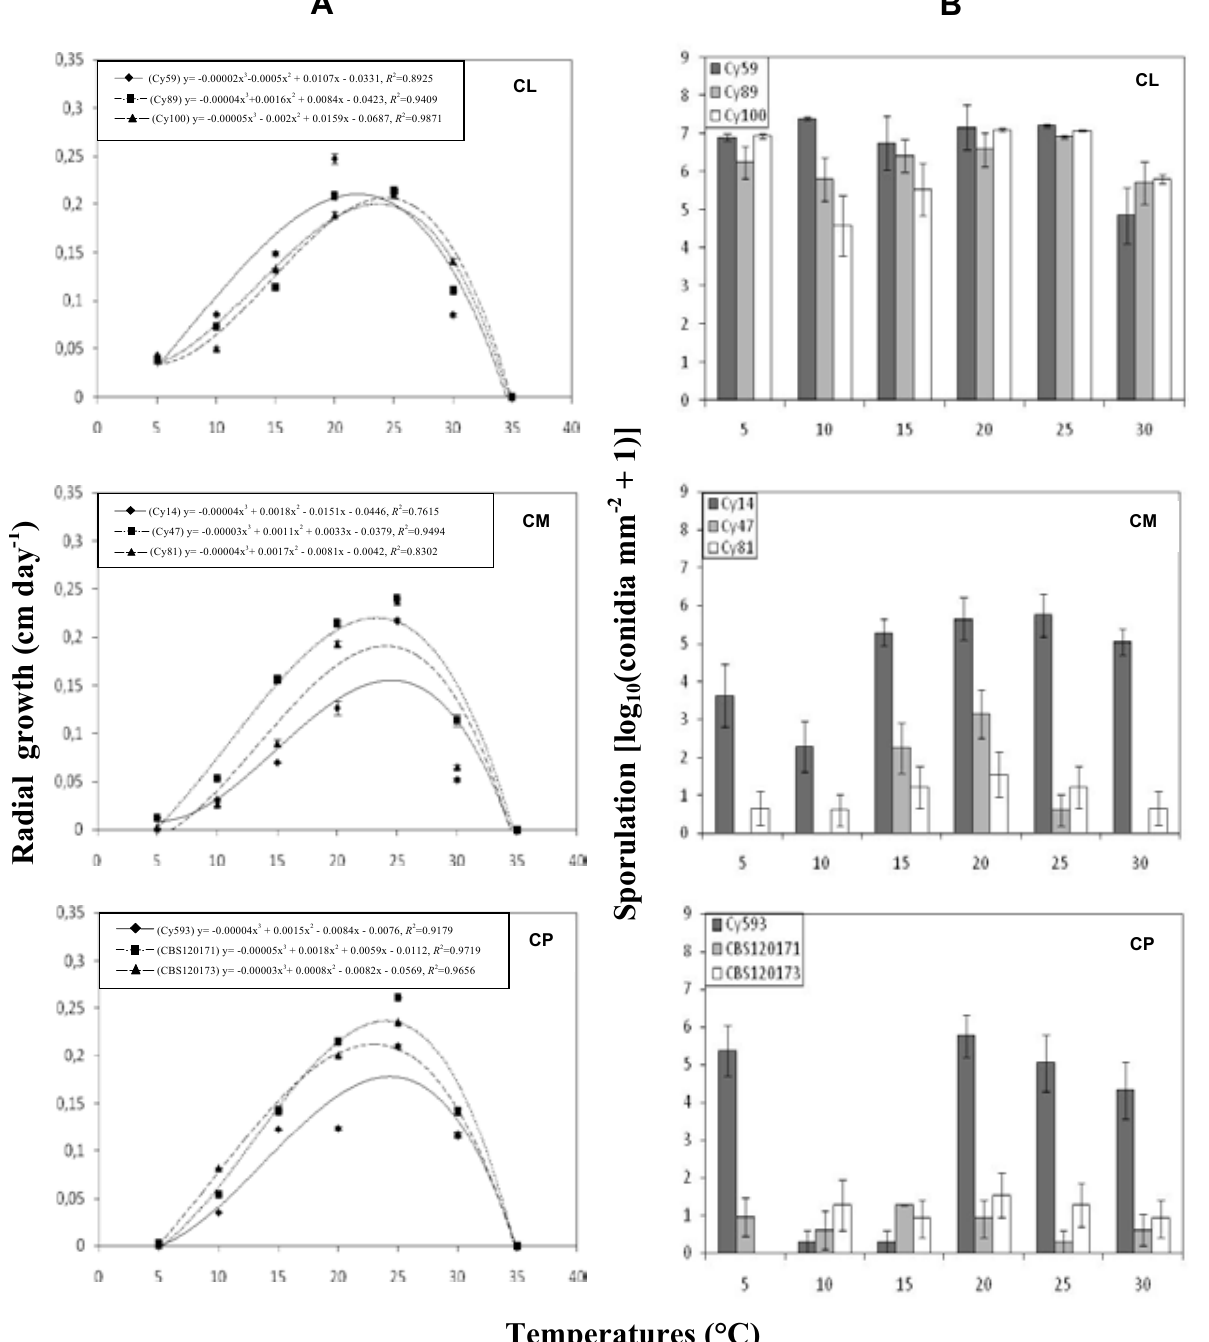
Figure 1. A , mean colony radial growth rates (cm day -1 ) of three isolates of C. liriodendi (CL) , C. macrodidymum (CM) and C. pauciseptatum (CP), after 10 days of incubation in darkness on PDA at 5, 10, 15, 20, 25, 30 or 35ºC; B, mean amounts of sporu- lation [log 10 (conidia mm -2 + 1)] of three isolates of C. liriodendri (CL) , C. macrodidymum (CM) and C. pauciseptatum (CP), after 30 days of incubation in darkness on PDA at 5, 10, 15, 20, 25, 30 or 35ºC . Results are the mean of two independent sets of four pseudoreplicates for each temperature. Vertical bars are the standard error of the